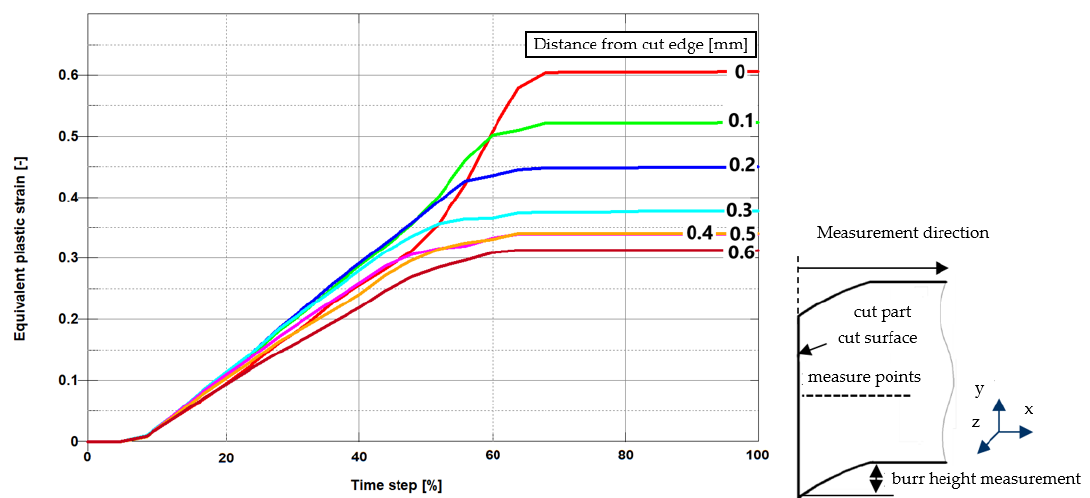
Figure 12. Graph of burr height obtained numerically and experimentally.